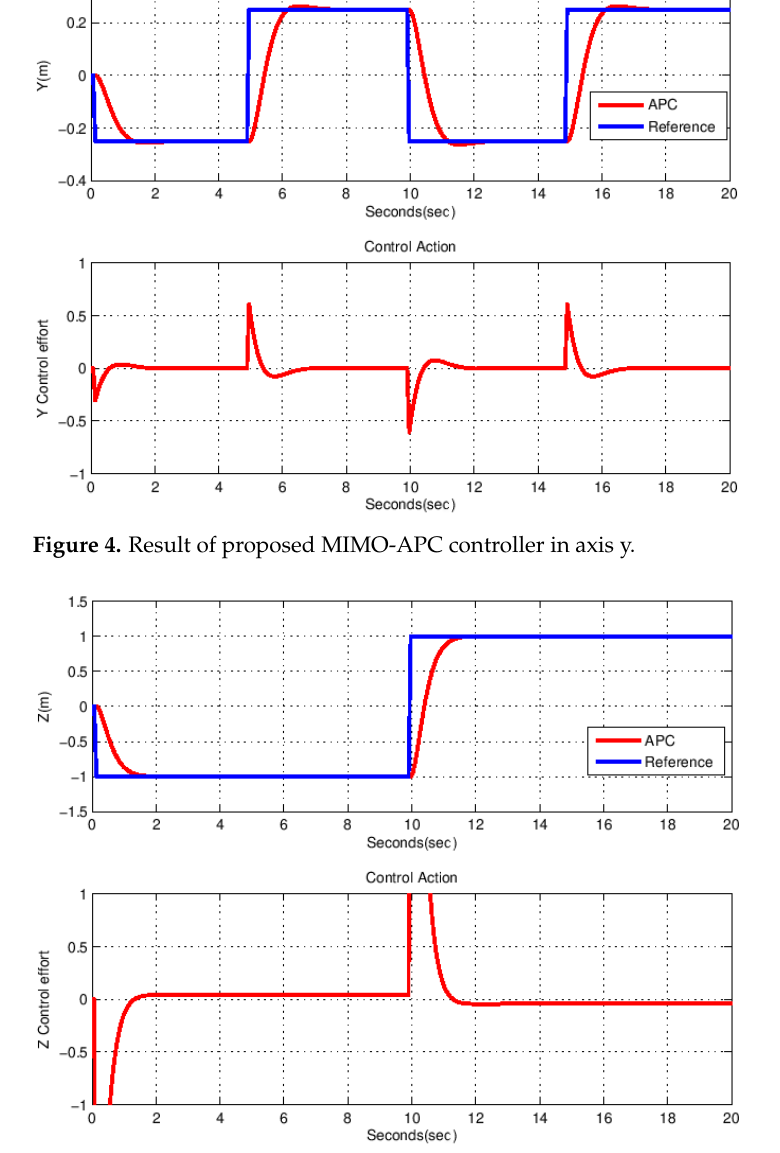
Figure 5. Result of proposed MIMO-APC controller in axis z. Table 1. Performance index for path-following